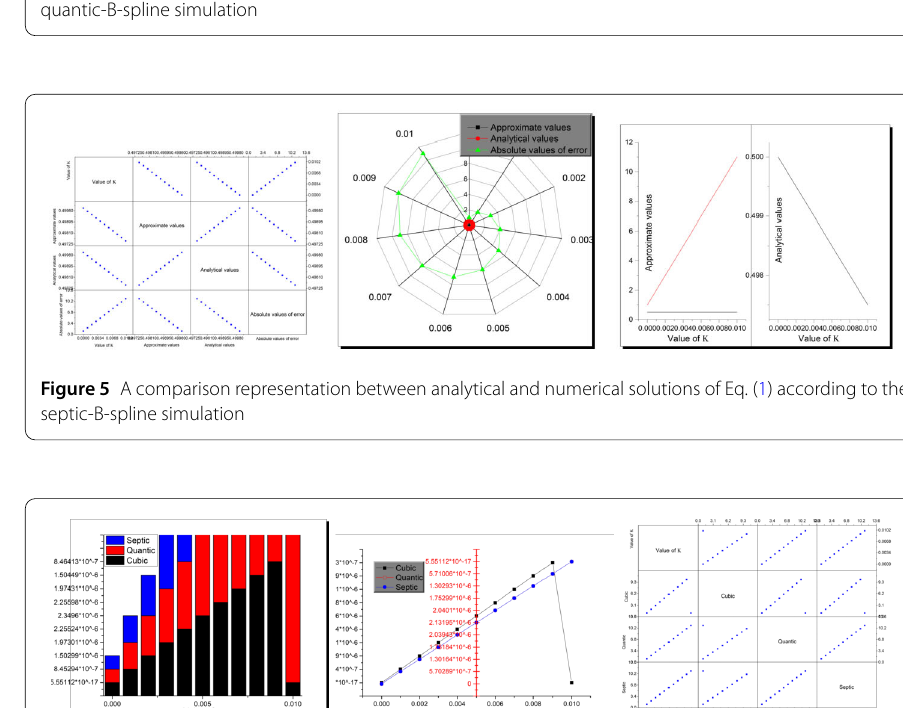
Figure 4 A comparison representation between analytical and numerical solutions of Eq. (1) according to the quantic-B-spline simulation